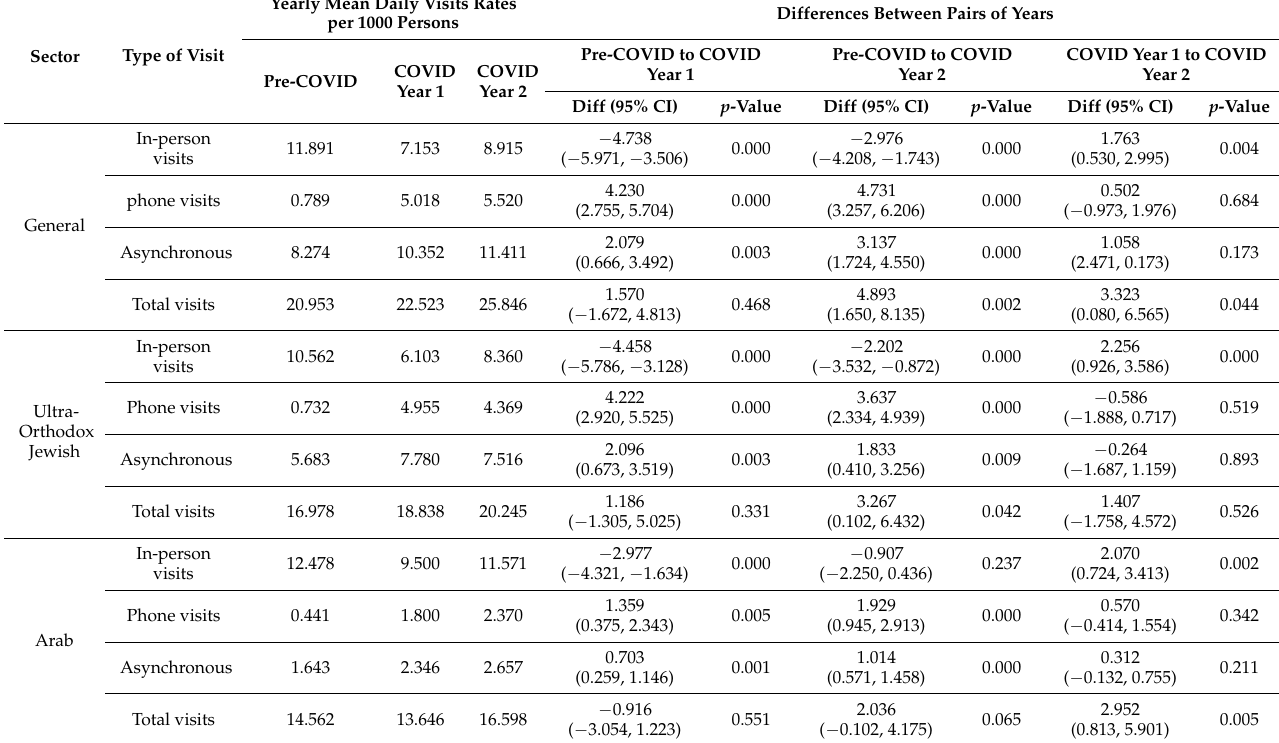
Table 4. ANOVA of visits by